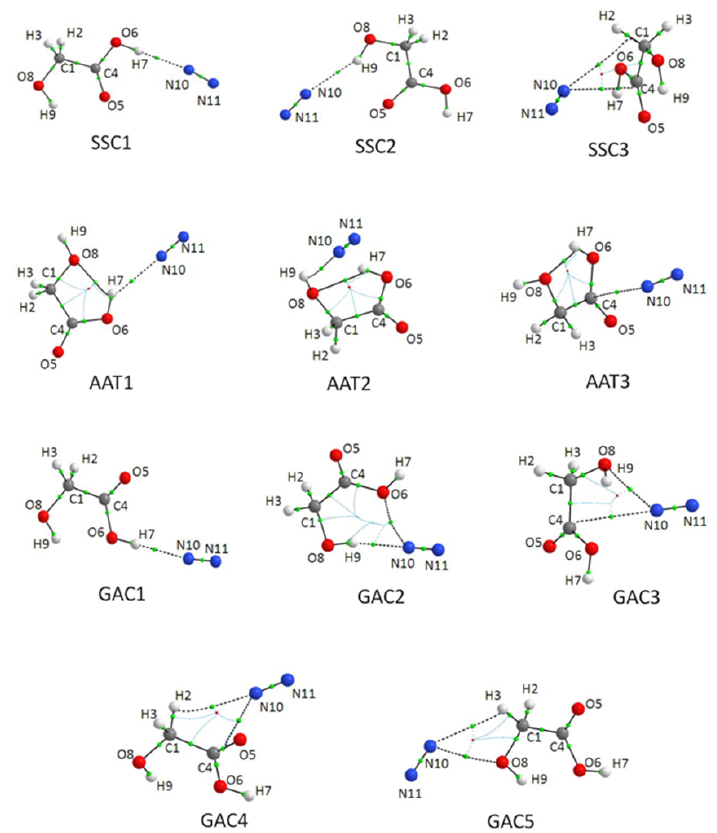
Figure 2. The MP2-optimized 1:1 structures of SSC, AAT and GAC complexes with molecular nitrogen.